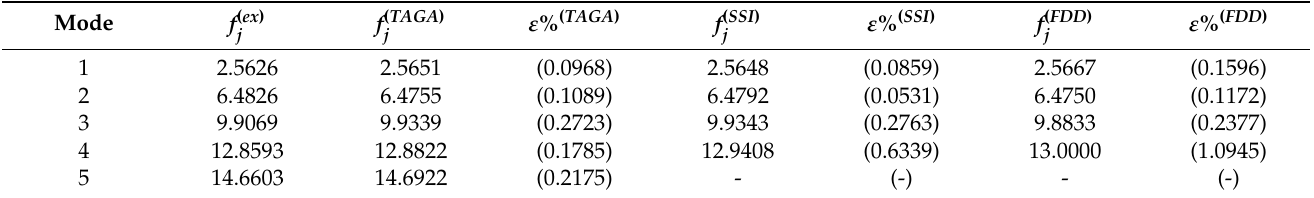
Table 7. Exact frequencies, identified frequencies, and corresponding discrepancies for the 5DoF system.